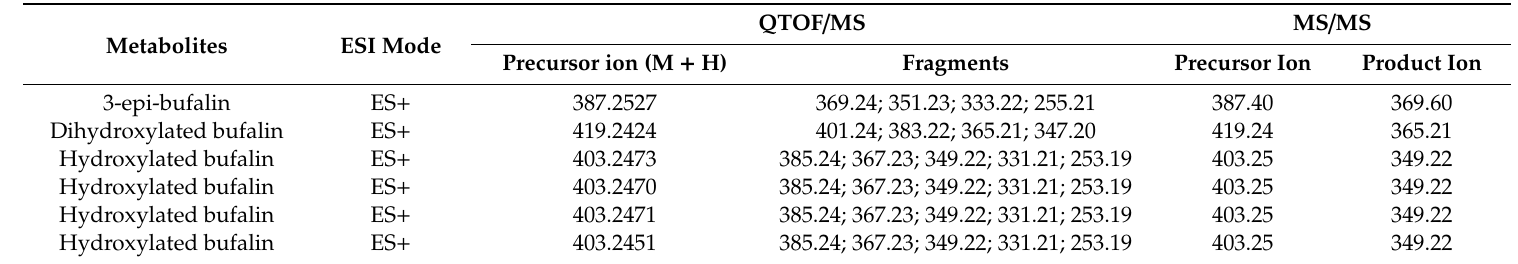
Table 2. Transformation of multiple reaction monitoring (MRM) settings of main metabolites from UPLC–QTOF / MS to LC–MS /